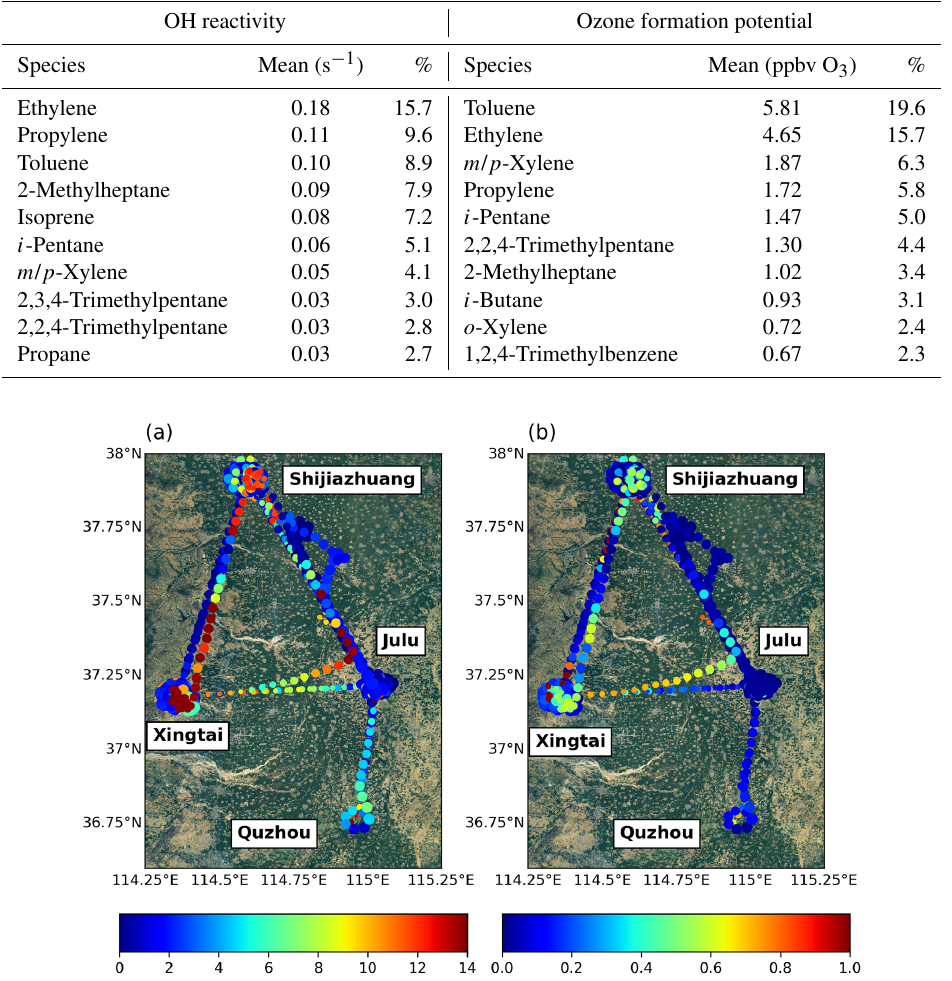
Figure 8. (a) Map of the net production rates of O 3 calculated using F0AM box model results along the Y-12 flight track during ARIAs. (b) Map of L N /Q , an O 3 sensitivity indicator, along the Y-12 flight path. Ozone production is VOC-sensitive when L N /Q> 0.5 and NO x -sensitive when L N /Q < 0.5 (Kleinman, 2005a). The size of the dots in both plots is proportional to the production rate of O 3 . The background map is provided by Esri ©